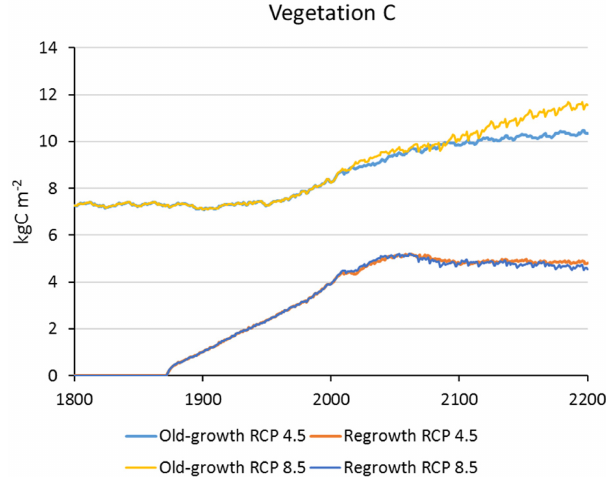
Figure E9. Simulations of European forests using automated thin- ning and clear-cutting in regrowth forests under RCP4.5 and RCP8.5 CO 2 and climate, recycling the last 30 data years after 2100. Vegetation carbon in old-growth and regrowth forests. Old- growth forests are simulated as